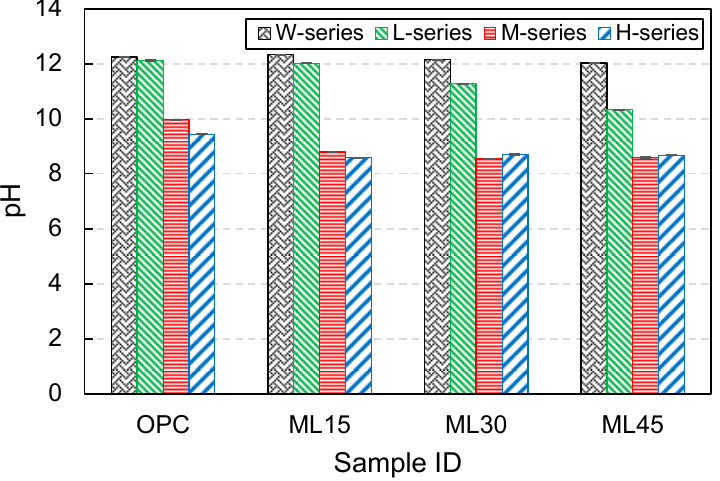
Figure 4. pH value of samples at 28 d of curing.